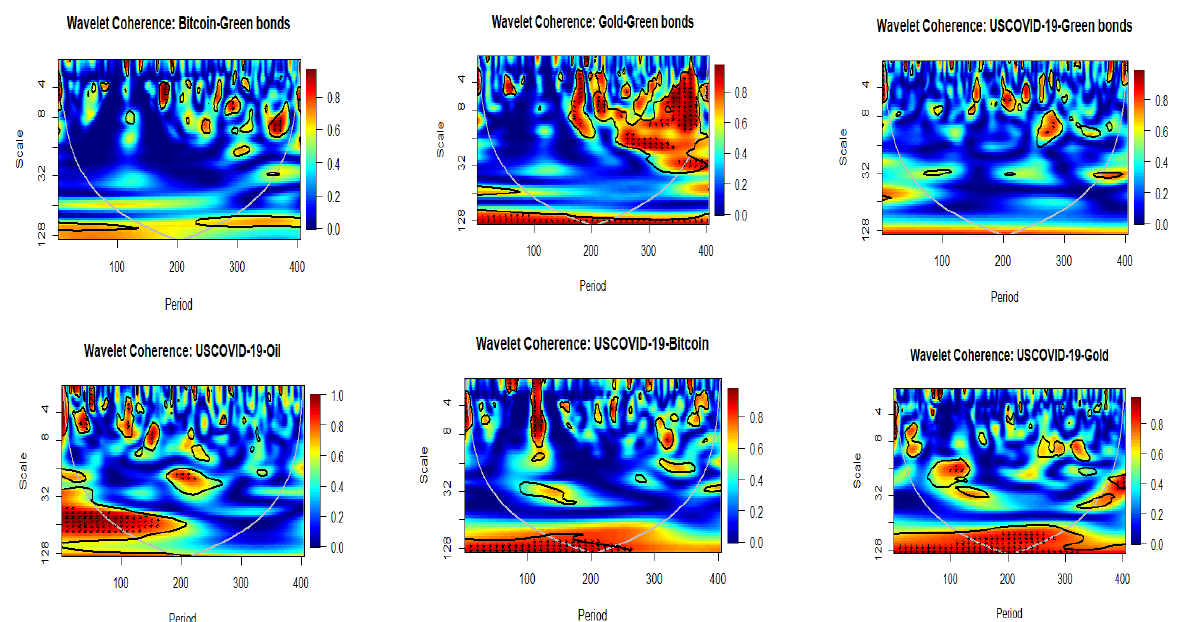
Table 2. The results for six sub frequency domains (D1–D6).